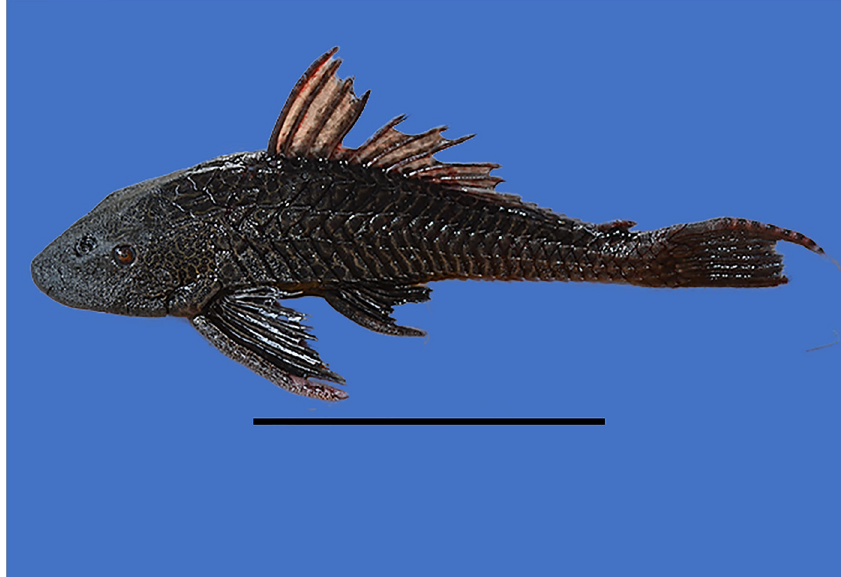
Figure 1. Pterygoplichthys pardalis from the Brazilian Amazon. (Scale bar = 10